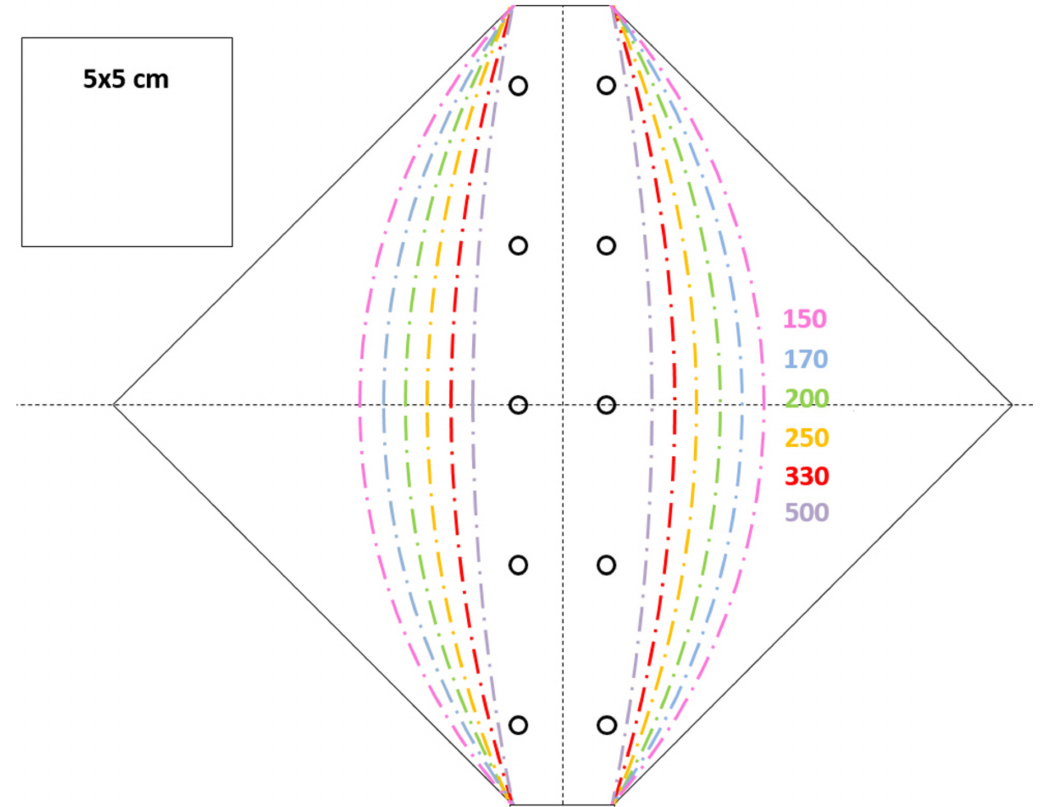
Figure 9. Printable template with six radii of